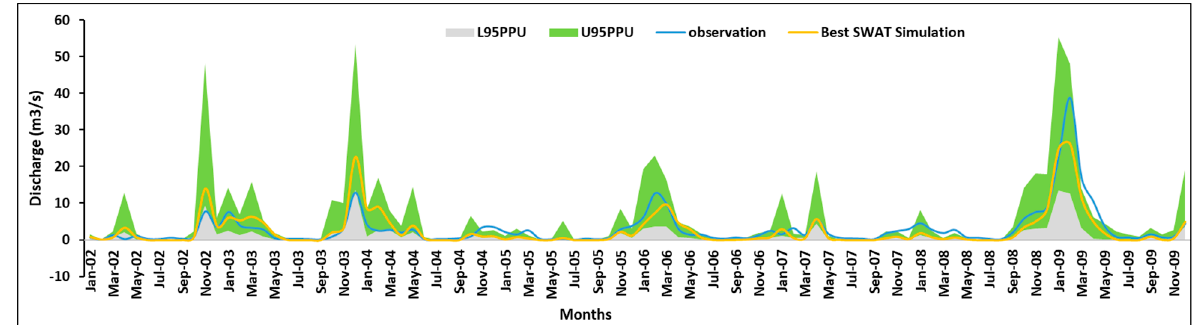
Figure 4. Observed and Simulated Monthly Streamflow for Souk Elhad station.